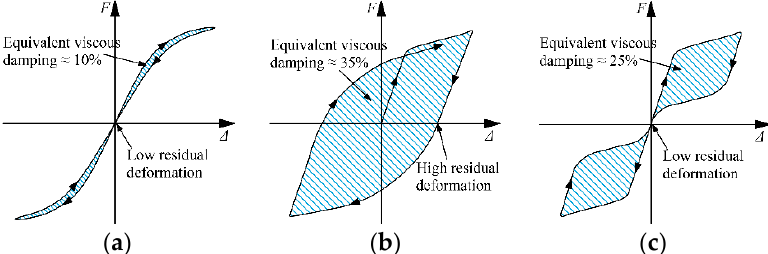
Figure 3. Description of hysteresis characteristics: ( a ) nonlinear elastic system; ( b ) tension-compression yield system; ( c ) hybrid connection system.